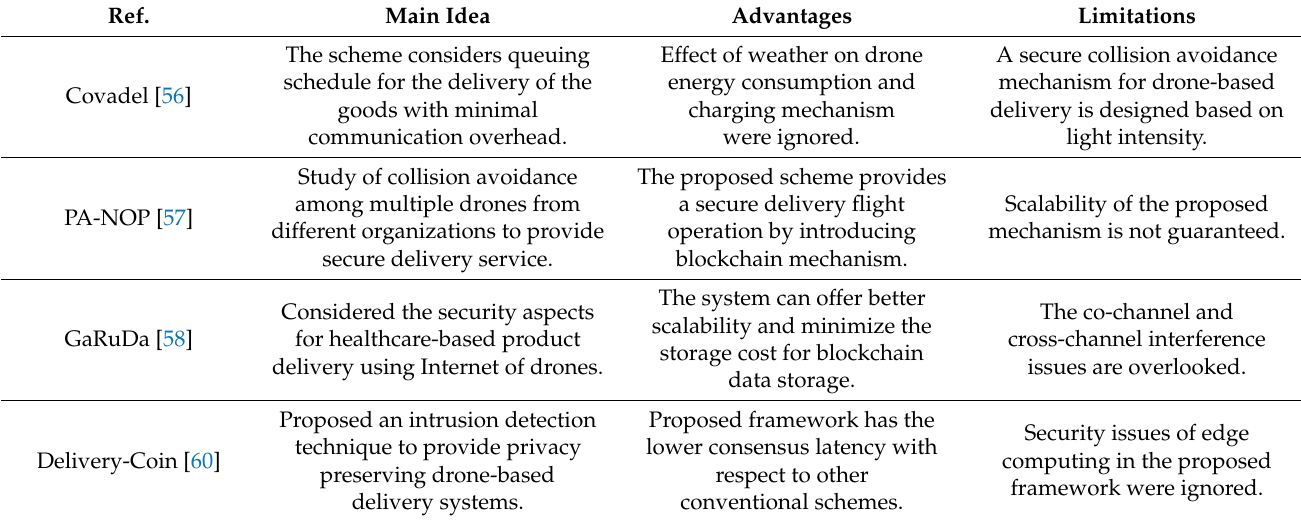
Table 6. Comparison of security algorithms in drone routing in terms of main idea, advantages, and